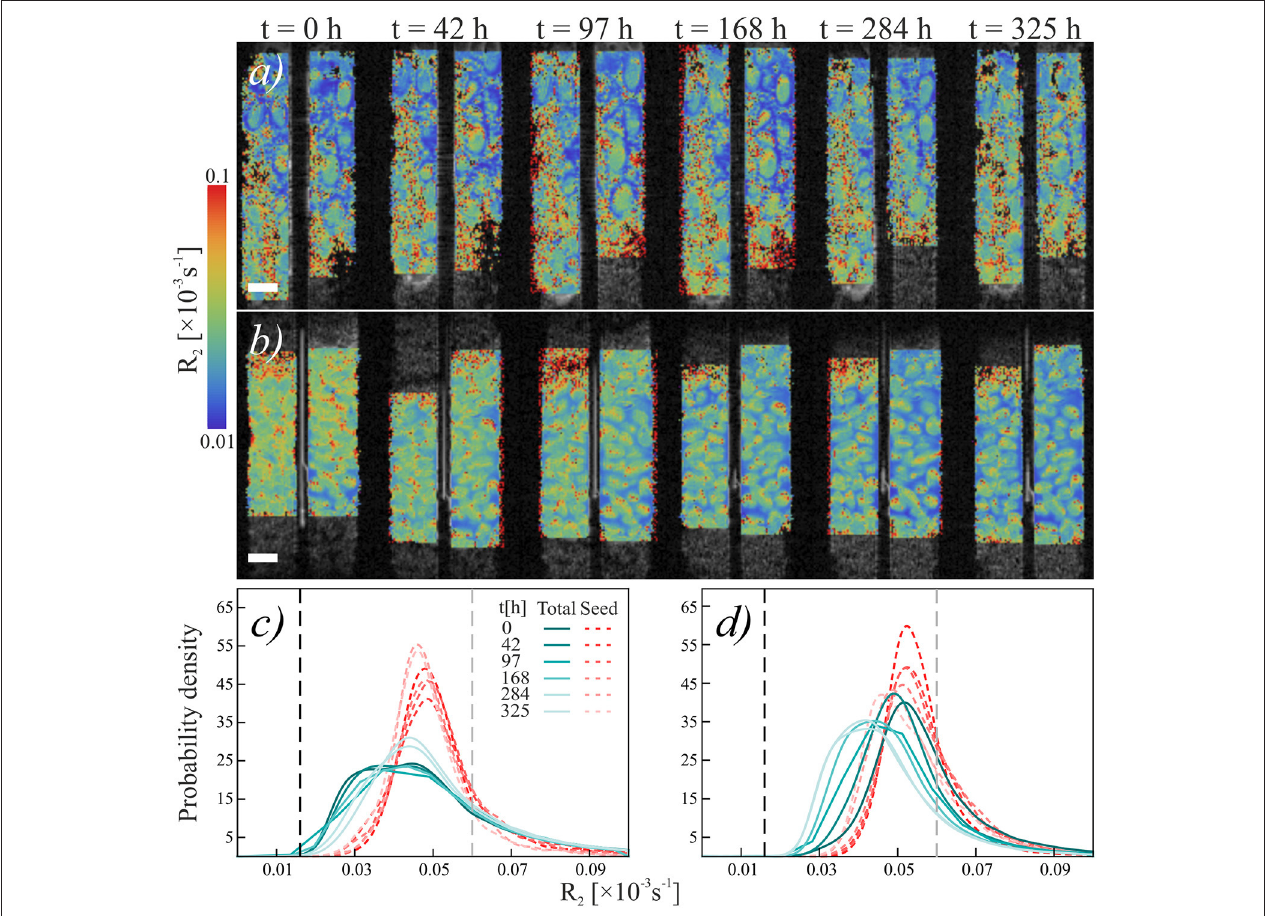
FIGURE 5 | Temporal development relaxation rate R 2 of chia seeds in quartz sand. (a,b) Temporal sequence of NMR scans of (a) loose chia in sand and (b) packed chia in sand. Colors indicate relaxation rate R 2 . Scale bars are 2mm. (c,d) Histograms of relaxation rate R 2 of (c) loose chia in sand and (d) packed chia in sand. Blue-green solid lines show R 2 in “Gel” region, red dashed lines show R 2 in “Seed” region. Black dashed reference line shows mean R 2 of water in the capillary, gray dashed reference line shows mean R 2 of water in quartz sand ( R 2 =